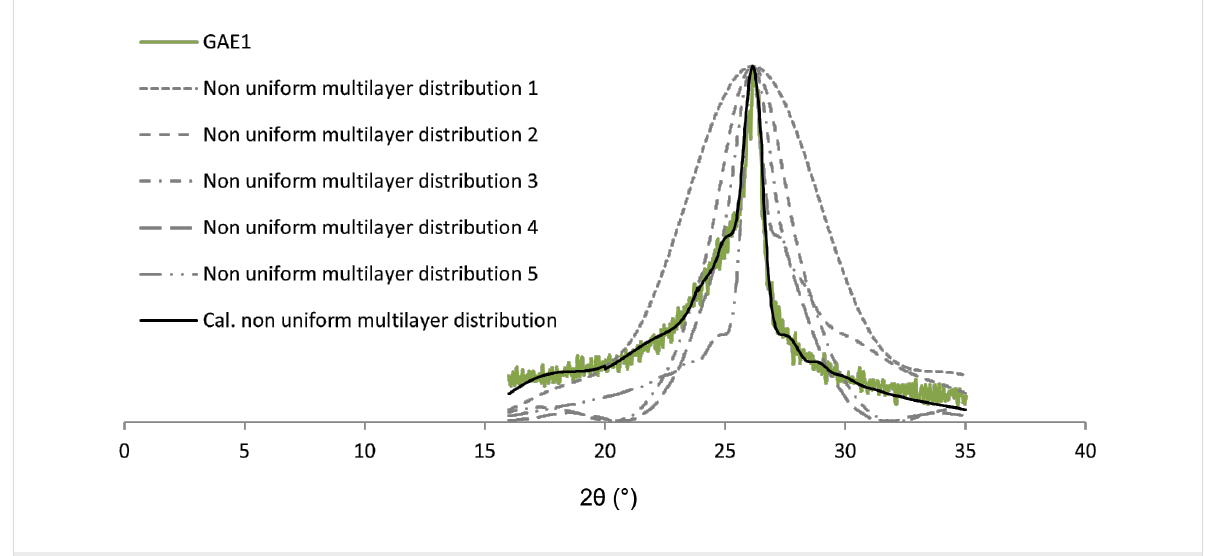
Figure 10: Nonuniform multilayer distribution curve for sample GAE1 calculated with Equation 3.